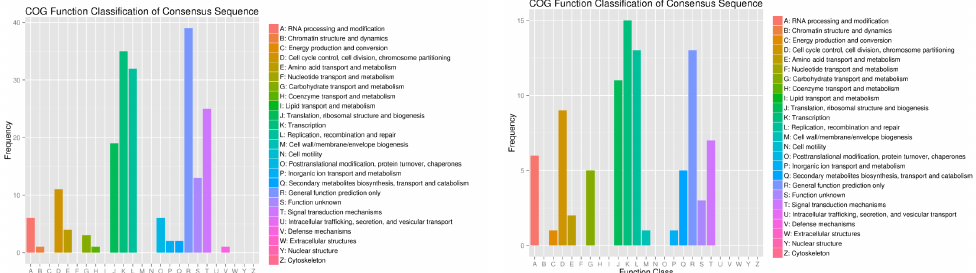
Figure 6. COG annotation classification of differentially expressed miRNA target genes. Figure 6 COG Annotation Classification of differentially expressed miRNA target genes.